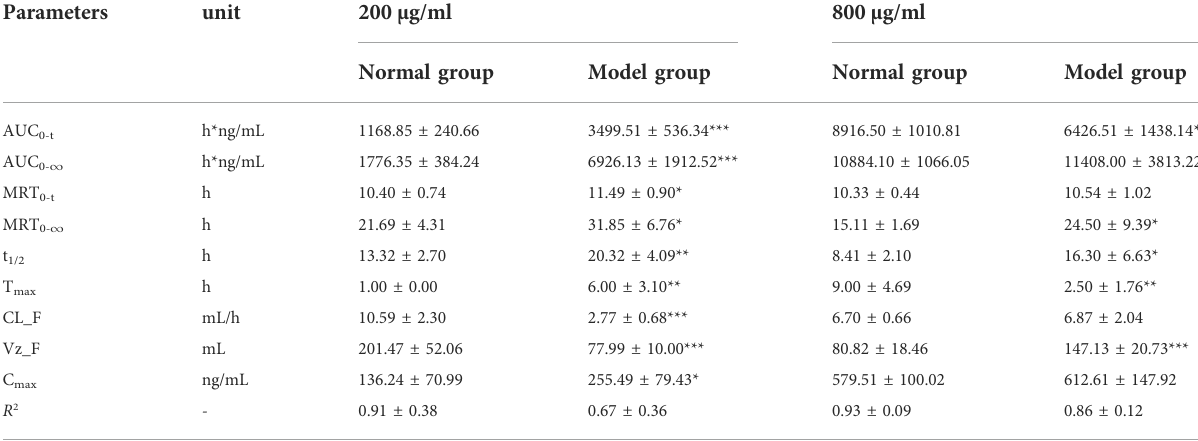
TABLE 5 The pharmacokinetic parameters of 3,4-dicaffeoylquinic acid in RAW264.7 cells after treatment with 200 μ g/ml and 800 μ g/ml of I. cappa extracts ( (cid:1) x ± SD, n = 6).